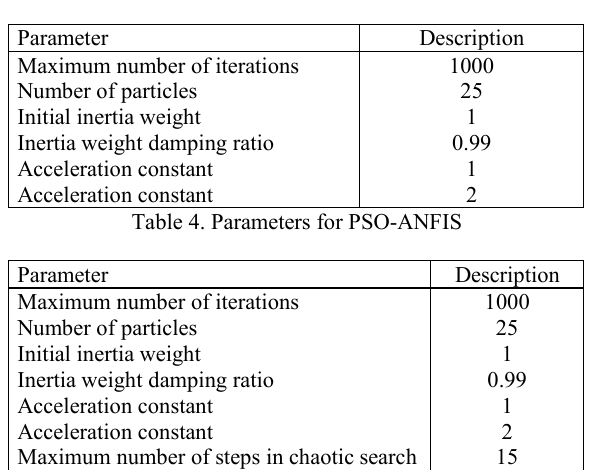
Table 3. Parameters for ANFIS